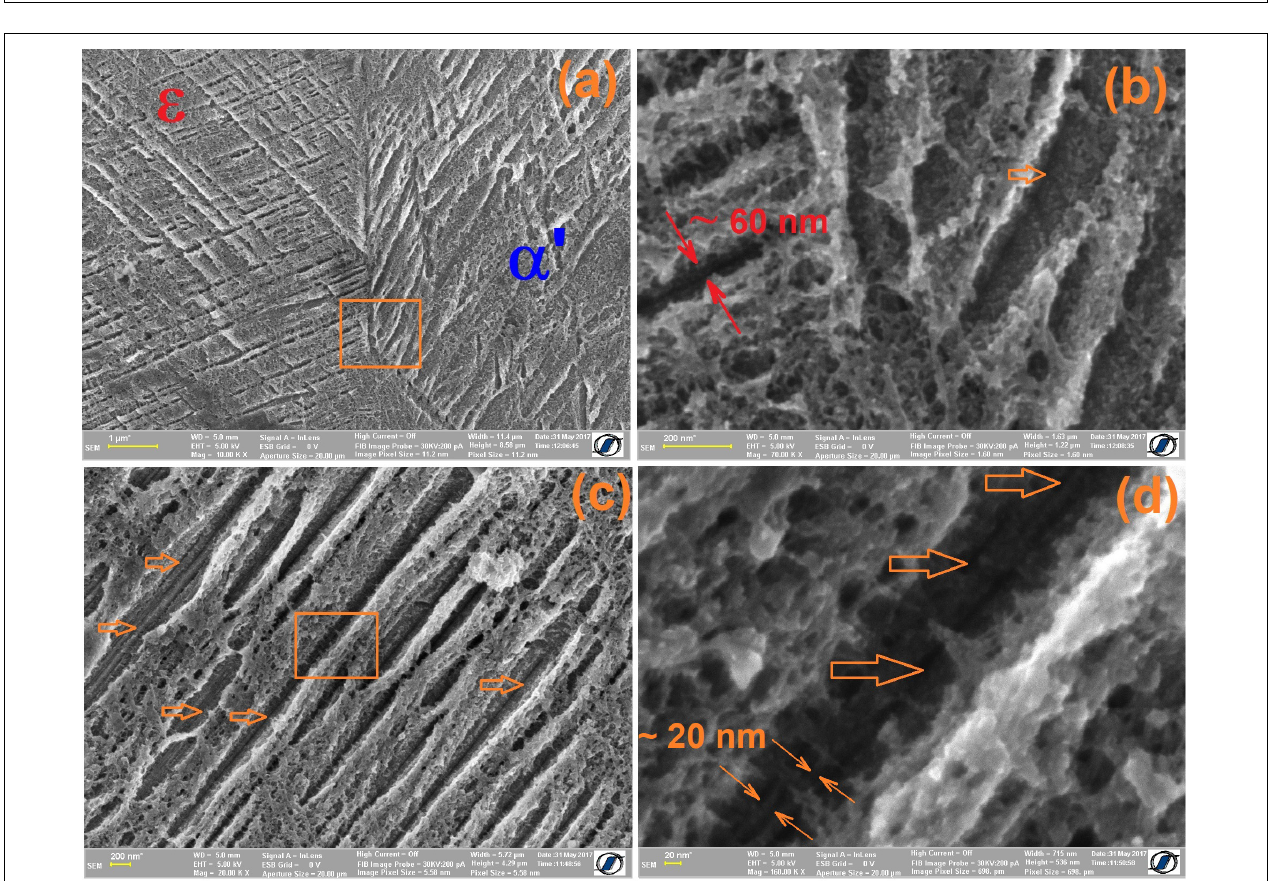
FIGURE 11 | (Sub)structural particularities of specimen 0_MA_1100 illustrated by HR-SEM: (a) grain boundary between neighboring regions with α (cid:48) -bcc and ε -hcp thermally induced martensite; (b) detail of the grain boundary from panel (a) with typical dimension of a ε -hcp martensite plate and one internal sub-band of α (cid:48) -bcc martensite; (c) multiple sub-bands identified within α (cid:48) -bcc martensite plates with single orientation and (d) detail from panel (c) typical dimension of identified α (cid:48) -bcc martensite sub-bands from panel (c) (reproduced after Pricop et al., 2018, with permission granted by Taylor &